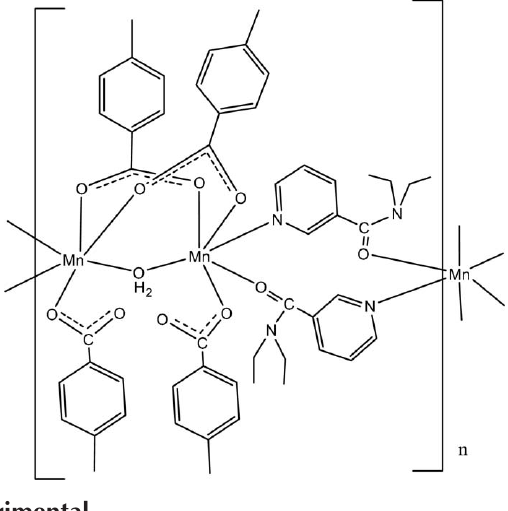
Experimental Crystal data